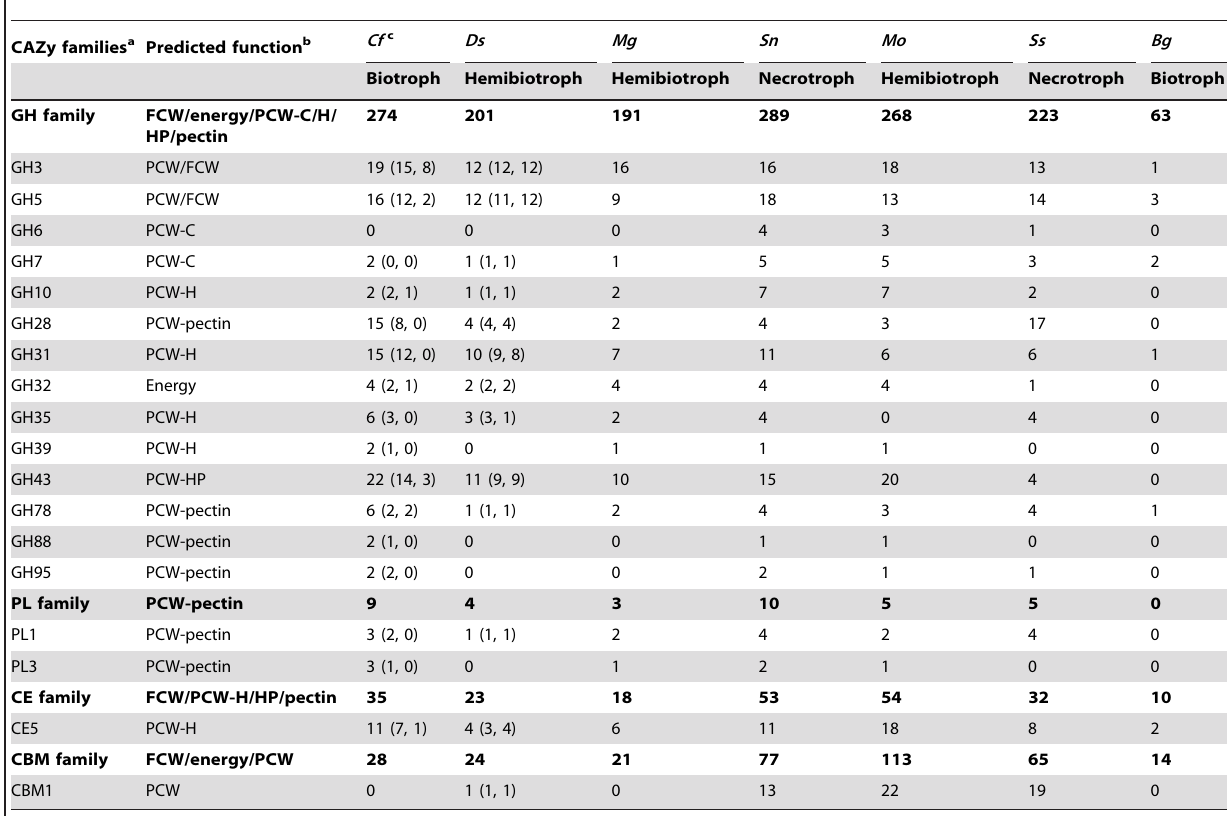
Table 6. Comparison of selected CAZy gene families between C. fulvum, D. septosporum , and five other Ascomycetes.